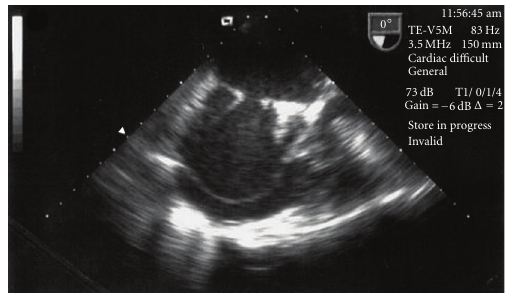
Figure 3: TEE recording where the thrombi are not